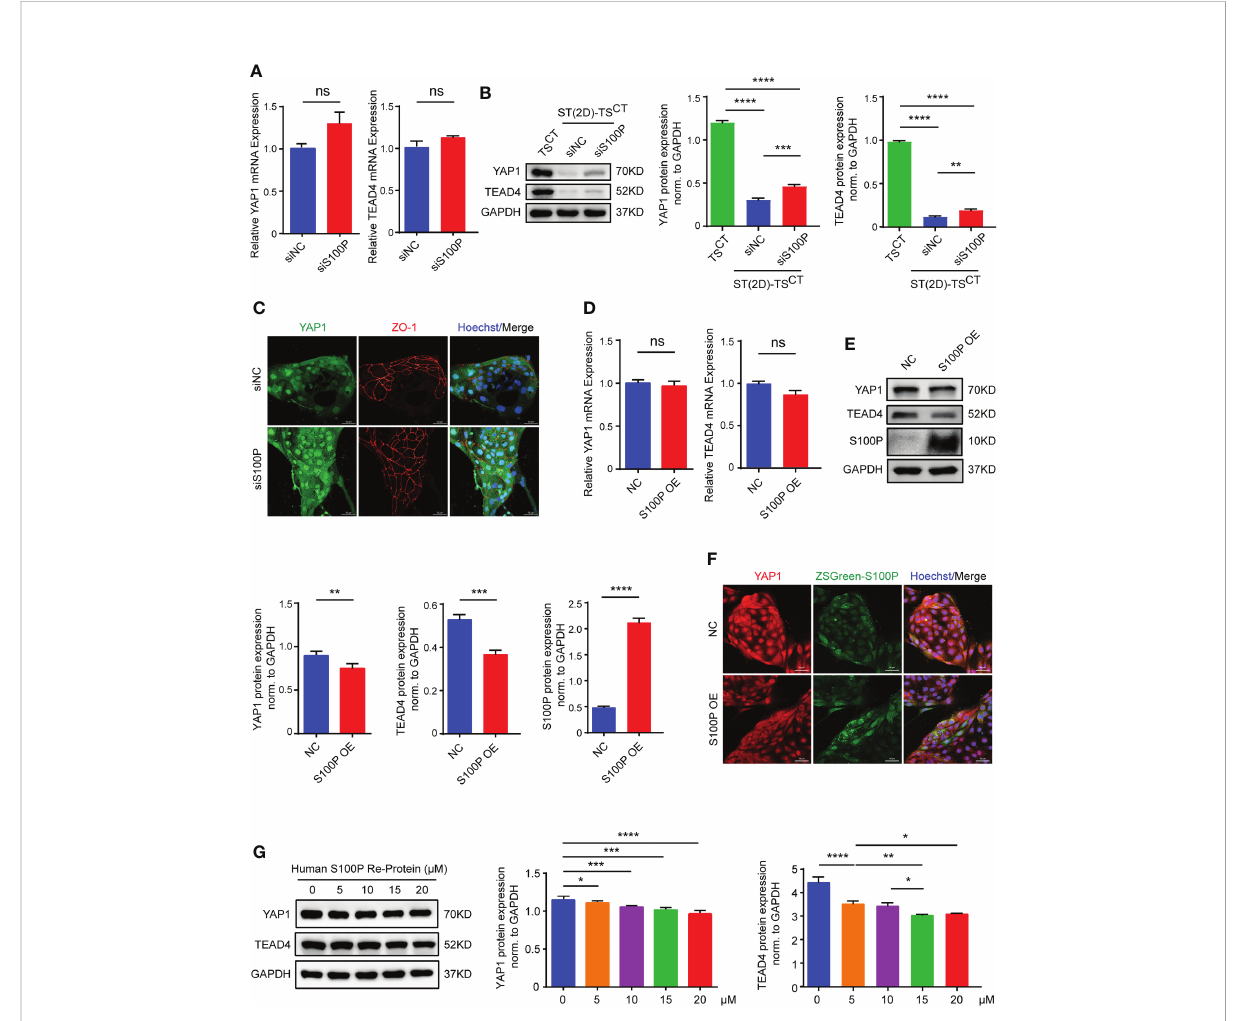
FIGURE 6 YAP1 and TEAD4 expression are increased in S100P -knockdown cells and decreased in S100P-overexpressing cells. (A) Quanti fi cation of YAP1 and TEAD4 mRNA expression. ST(2D)-TS CT cells transfected with siRNA underwent syncytialization for 6 days (n=3). All the bar graphs depict the mean values ± SEMs (normalized to GAPDH ), and the values were measured in duplicate; ns: p =0.0739, p =0.1537. (B) Representative Western blotting of YAP1 and TEAD4 protein levels in TS CT and ST(2D)-TS CT cells that were transfected with siS100P and underwent syncytialization for 6 days (n=3). Semi quanti fi cation of YAP1 and TEAD4 protein expression normalized to GAPDH (n=3). ** p =0.0023; *** p =0.0007; **** p <0.0001. (C) Representative immuno fl uorescence images of staining for YAP1 and the TS CT cell boundary marker ZO-1. Hoechst staining indicates nuclei (n=3). Scale bars, 50 m m. (D) Quanti fi cation of YAP1 and TEAD4 mRNA expression was performed by qPCR. TS CT cells were infected with a lentiviral vector inducing overexpression of S100P (n=3). All the bar graphs show the mean values ± SEMs (normalized to GAPDH ). ns: p =0.1643, p =0.0796. (E) Representative Western blotting of YAP1, TEAD4, and S100P expression in S100P -overexpressing TS CT cells. Semi quanti fi cation of YAP1, TEAD4 and S100P protein expression normalized to GAPDH (n=3). ** p =0.0018; *** p =0.0006; **** p <0.0001. (F) Representative immuno fl uorescence images of ZSGreen-S100P and YAP1 staining. Hoechst staining indicates nuclei. Scale bars, 50 m m. (G) Representative Western blotting of YAP1 and TEAD4 expression in TS CT cells treated with recombinant human S100P protein (5 m M, 10 m M, 15 m M, and 20 m M) (n=3). Semi quanti fi cation of YAP1 and TEAD4 protein expression normalized to GAPDH (n=3). * p =0.0151, p =0.0126, p =0.0203; ** p =0.0051; *** p =0.0005, p =0.0001; **** p